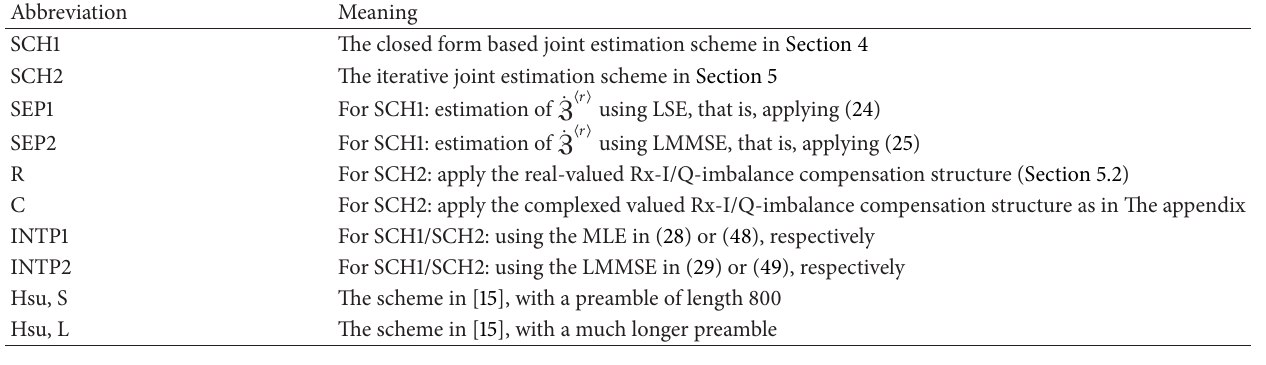
Table 1: Abbreviations in simulation results.